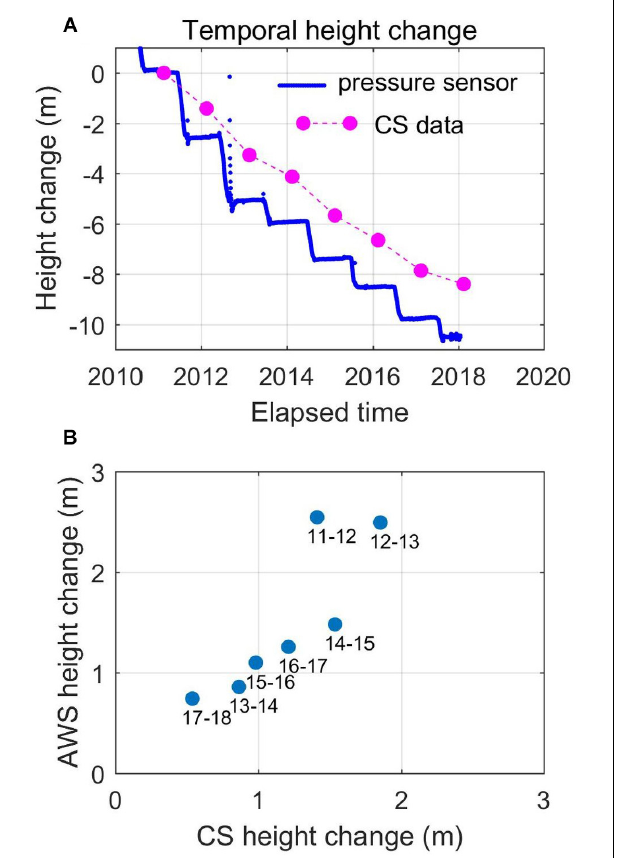
FIGURE 5 | (A) Ice melt from the UPE-U AWS ablation pressure sensor is shown in blue, and the winter-to-winter CryoSat height change interpolated to the position of the UPE-U AWS is shown in red. (B) Plot of the winter-to-winter height change for the CryoSat and ablation sensor data (at 15 February each